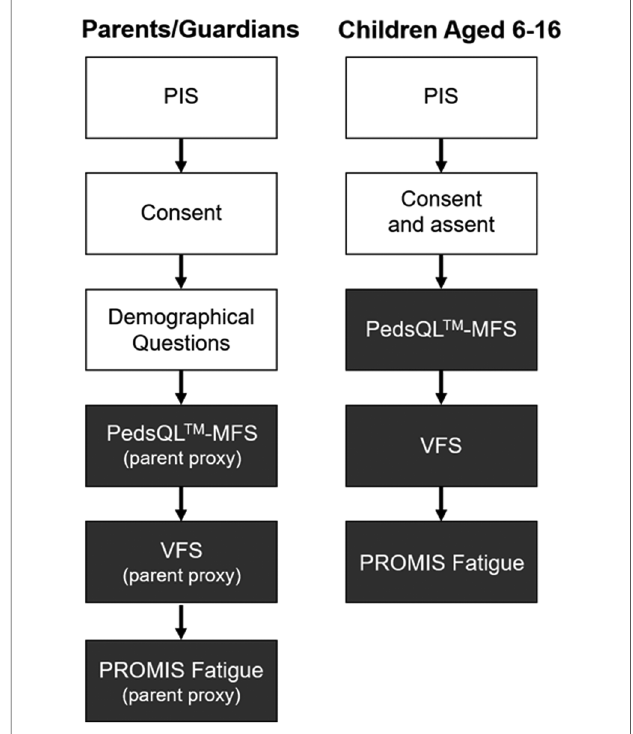
FIGURE 1 Flowchart of study format for parent/guardian and child participants. For child self-report section, parent consented for children aged 6-15 years old, and children assented. Children who were aged 16 provided their own consent. PIS=Patient Information Sheet. Shaded boxes are fatigue